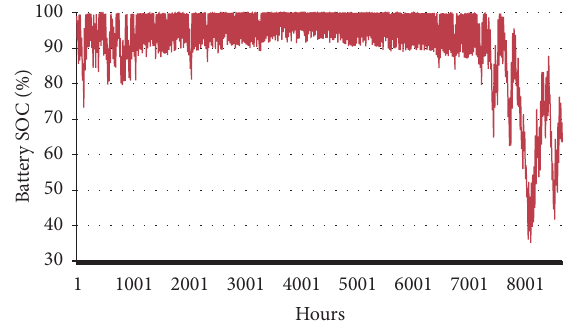
Figure 7: Simulation result of battery SOC.